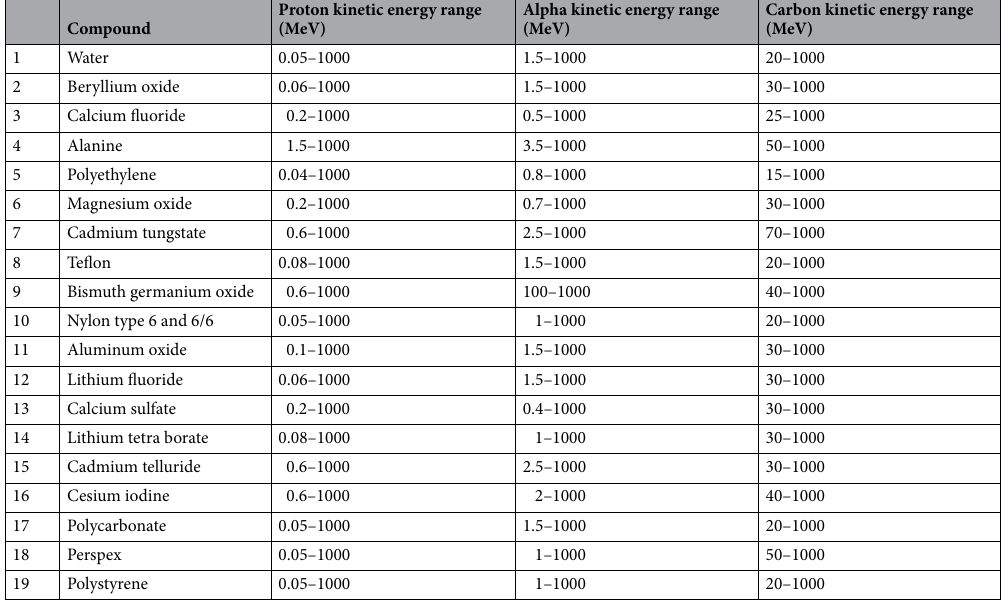
Table 4. Valid kinetic energy range for proton, alpha, and carbon